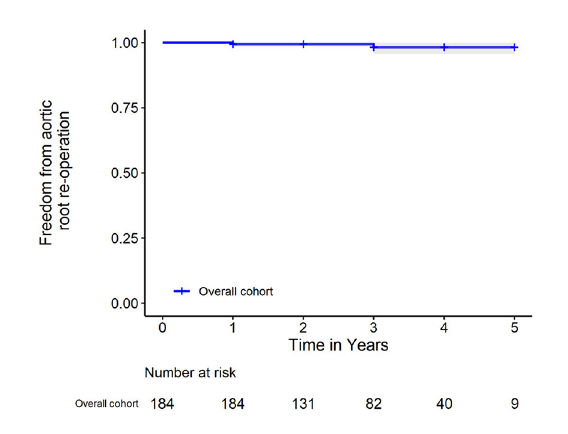
FIGURE3 Kaplan-Meier analysis of freedom from aortic root reoperation. The shadow area represents the 95% confidence interval.